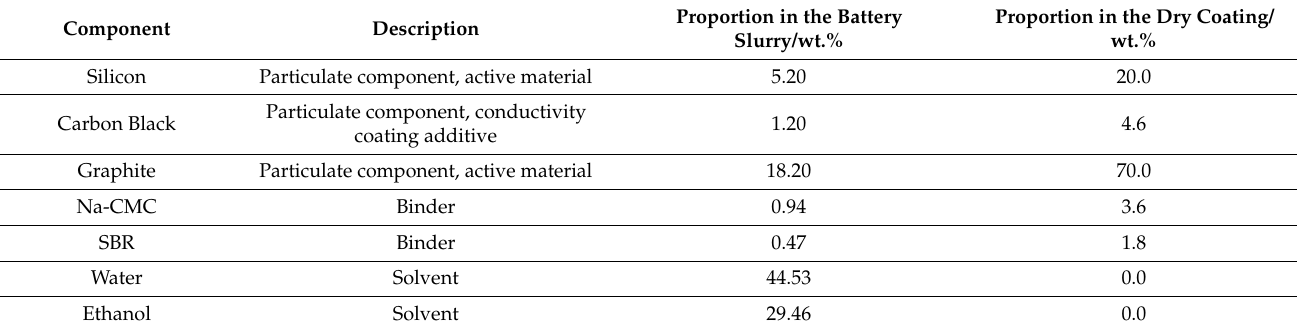
Table 1. Mass proportion of each component in the battery slurry and the dry battery coating.